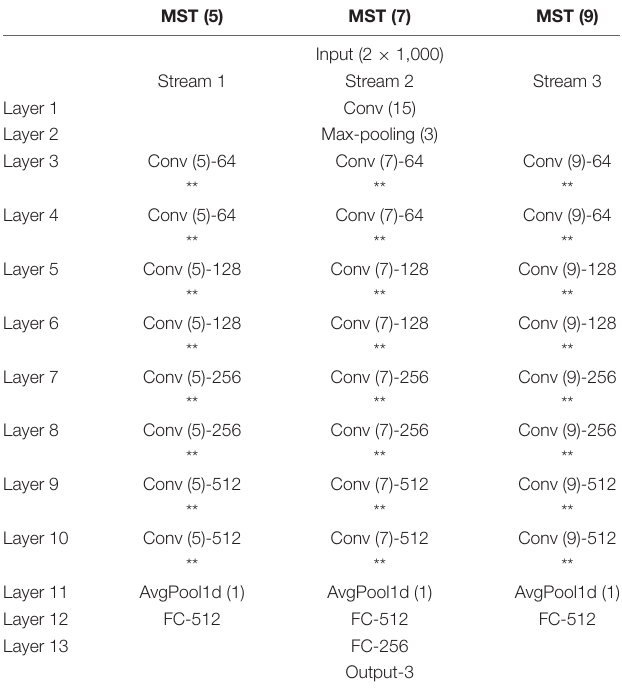
**Represents “Batch Normalization layer + non-linear function rectifier linear